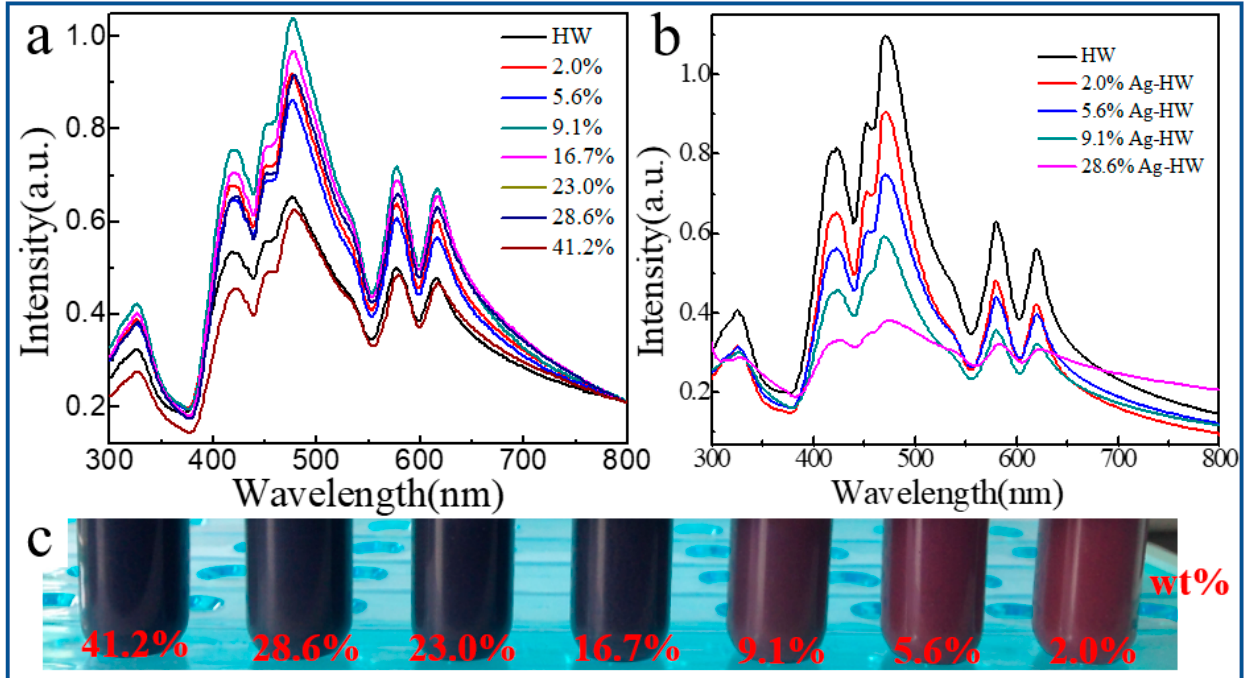
Figure 4. The absorption spectrum of M-HW nanocomposites with different metal NPs loadings ratios. ( a ) Pt-HW; ( b ) Ag-HW; ( c ) optical photographs of Pt-HW nanocomposites. All metal NPs loading proportions were represented in wt% unless otherwise stated.